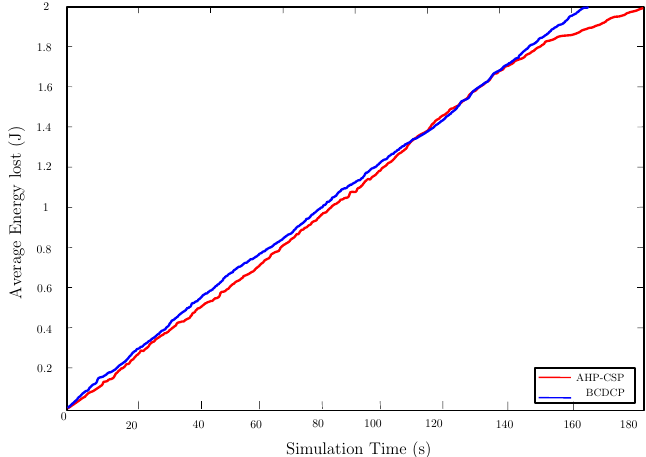
Figure 9. A comparison between AHP-CSP and BCDCP in terms of average lost energy.